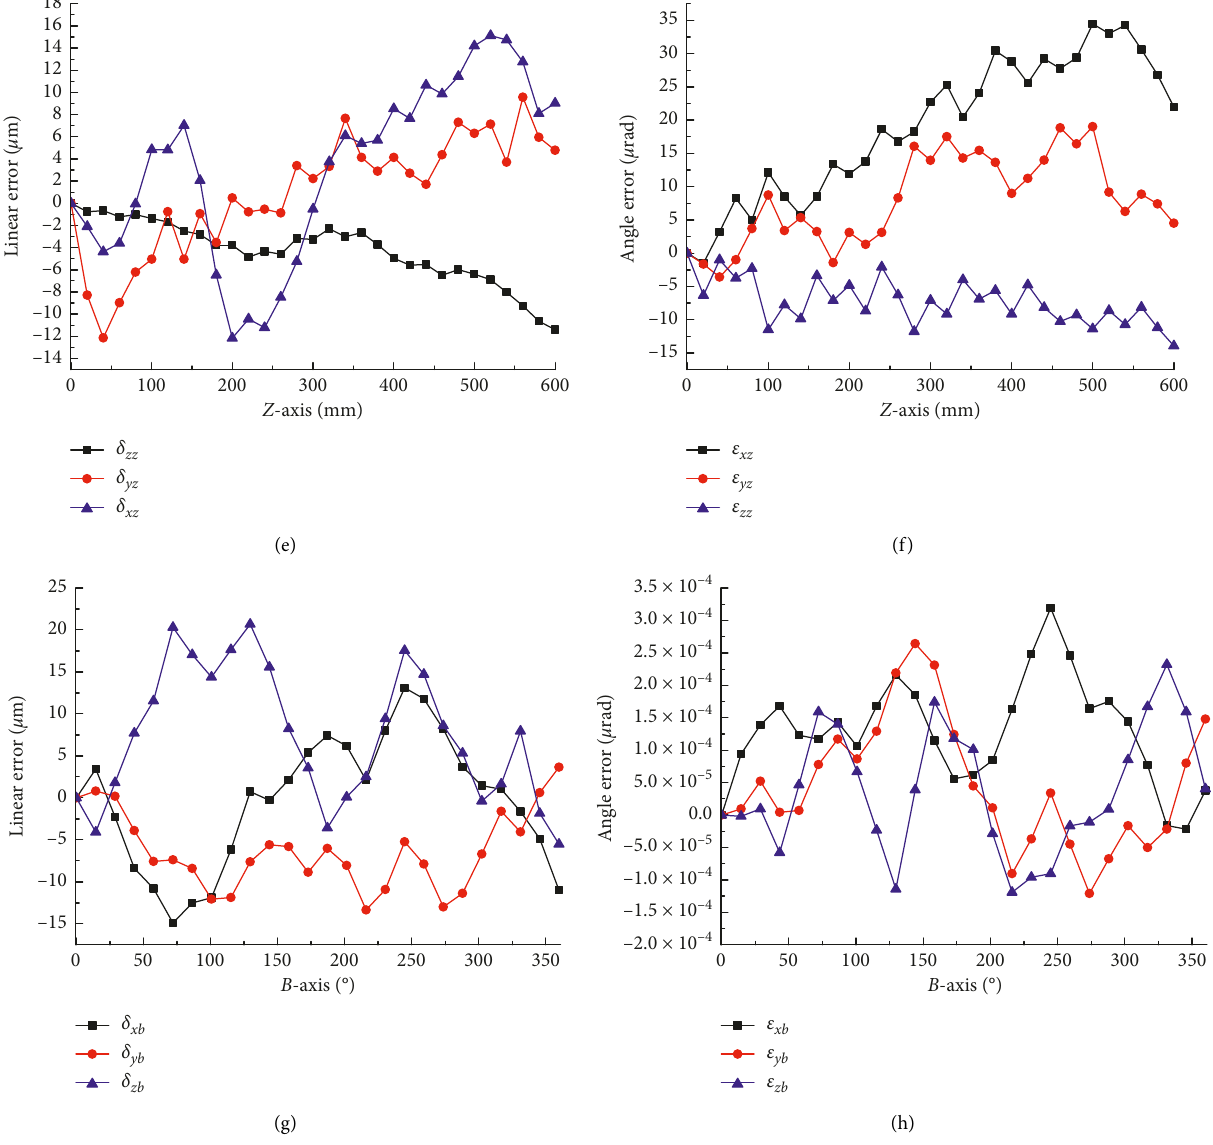
Figure 5: Identified values of geometric error. (a) Linear errors of the X -axis. (b) Angle errors of the X -axis. (c) Linear errors of the Y -axis. (d) Angle errors of the Y -axis. (e) Linear errors of the Z -axis. (f) Angle errors of the Z -axis. (g) Linear errors of the B -axis. (h) Angle errors of the B -axis. Table 3: Identified values of